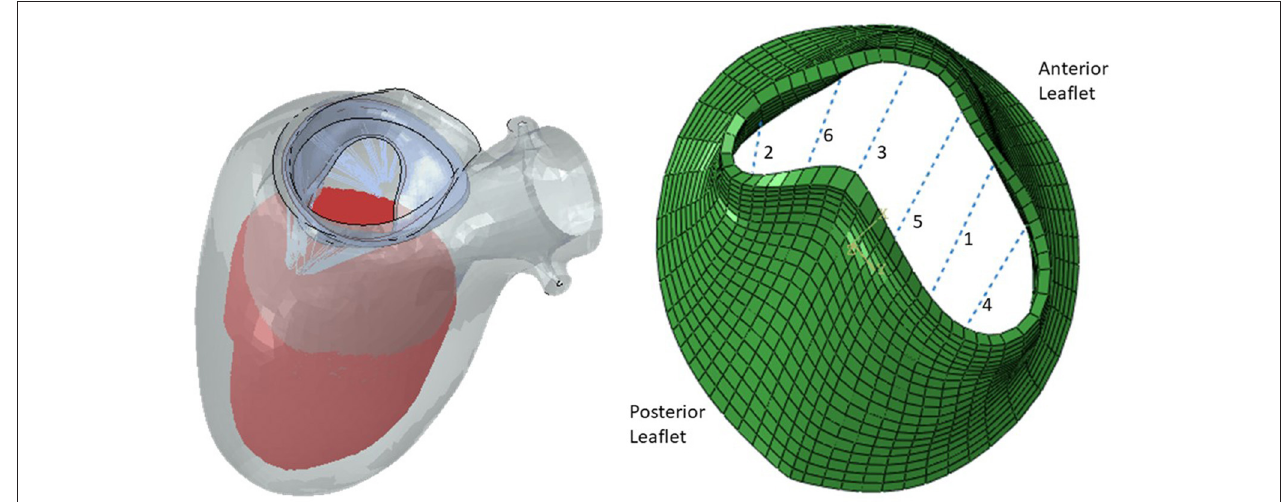
FIGURE 3 | The FE model (left) and the MV (right) . The six locations for MC are shown.